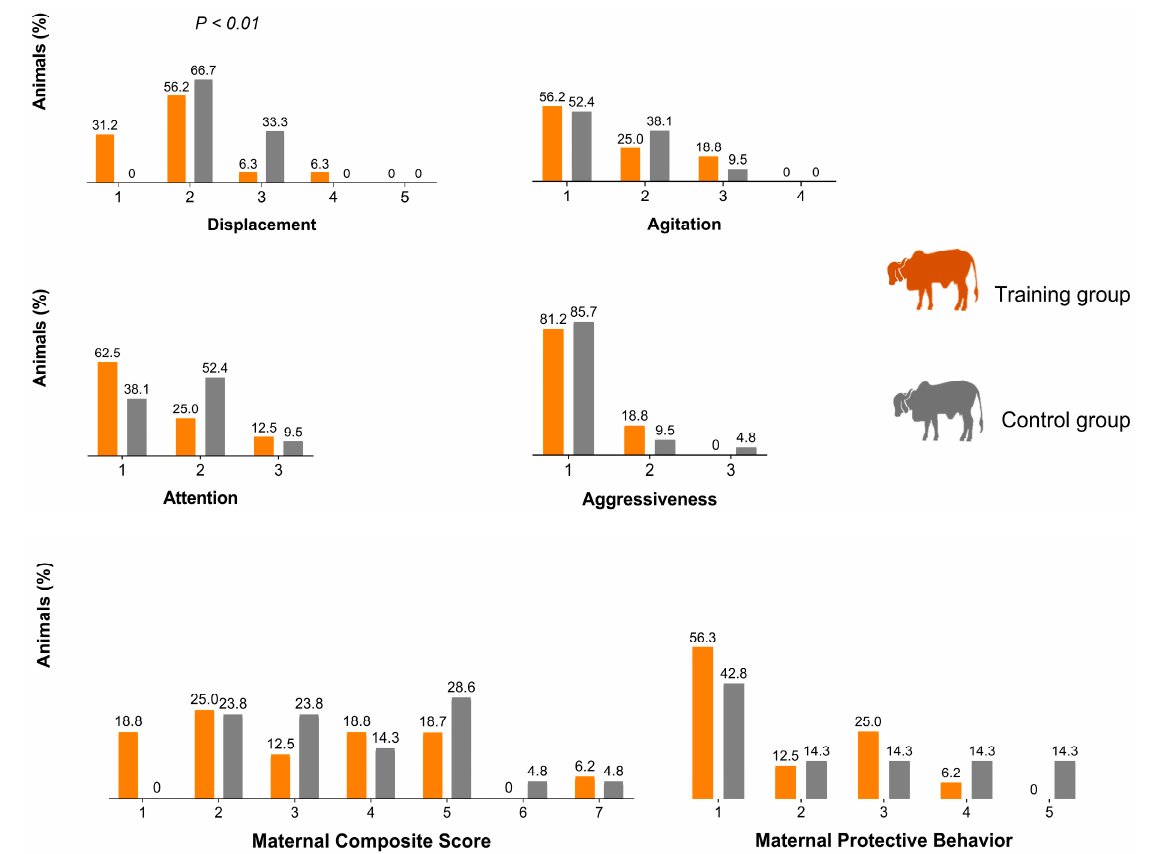
Figure 1. Distribution of displacement, agitation, attention, and aggressiveness scores, maternal composite score (MCS), and maternal protective behavior (MPB) of primiparous Gyr dairy cows at the first handling of their calves.